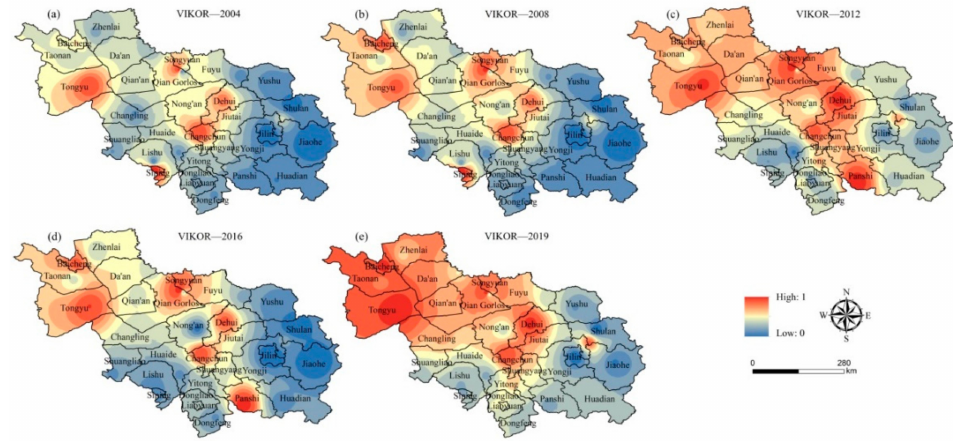
Figure 7. Spatial distribution of drought risk based on the VIKOR